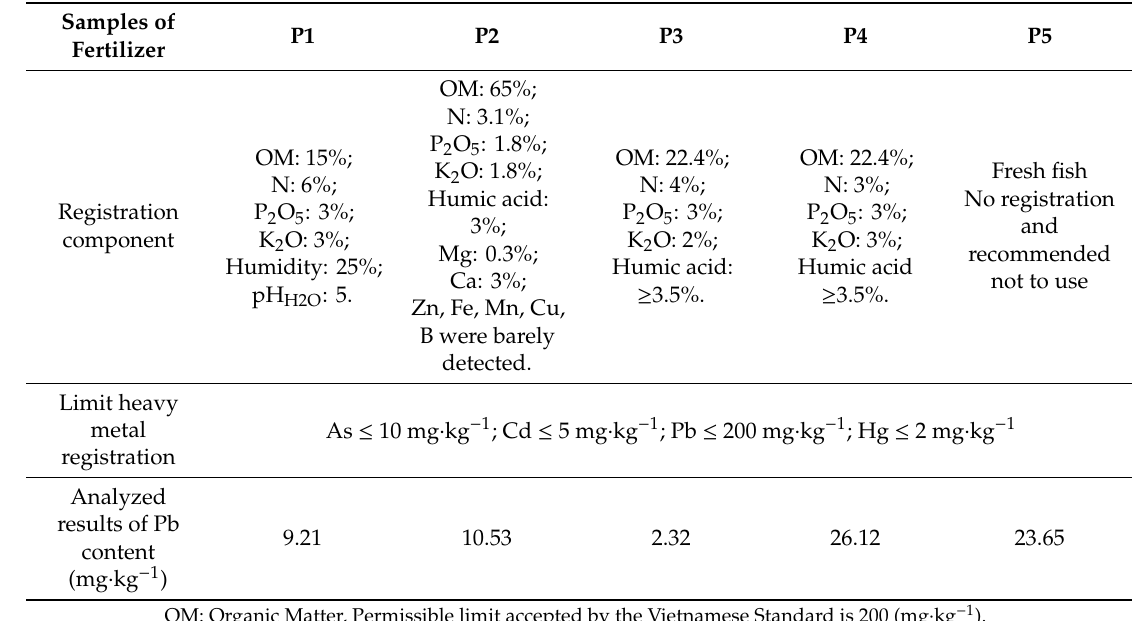
Table 2. Fertilizer samples used by